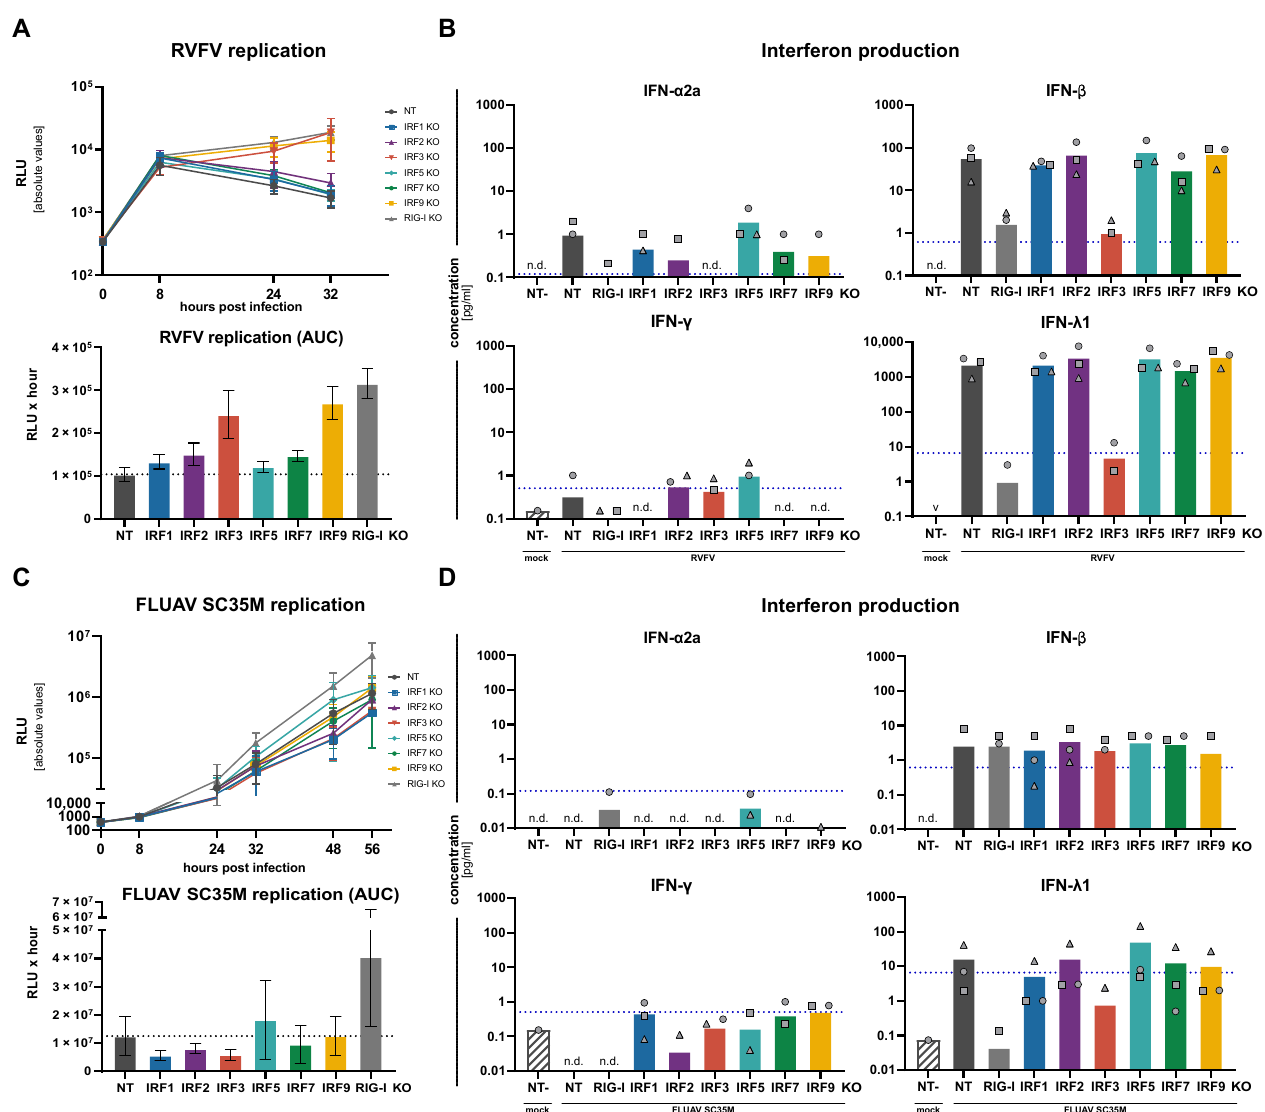
Figure 5. Impact of IRF KO on RNA virus replication and IFN production. A549 NT , A549 IRF (as indicated) KO , and A549 RIG-I KO cells were infected with Rift Valley fever virus (RVFV ∆ NSs-R-Luc) at an MOI of 0.01 ( A , B ), or with Influenza A Virus SC35M (FLUAV SC35M G-Luc) at an MOI of 0.001 ( C , D ). ( A , C ) Viral replication was assessed by measuring luciferase reporter activity at the indicated time points (top panels); the area under the curve (AUC) of the time courses is shown in the lower panels. Viral replication time-courses and AUC plots show mean ± SD of three independent experiments. ( B , D ) Supernatants of the infected cells were sampled at 32 h.p.i. (RVFV, B ) or 48 h.p.i. (FLUAV, D ) and analyzed for their IFN contents by an electroluminescent multiplex assay. Bars show means of three independent experiments with the three individual data points shown as symbols (same shapes indicate same experiment). “n.d.” indicates all measurements were non-detectable, “ ∨ ” indicates all measurements being below the cut-off of the Y-axis, and missing symbols indicate individual measurements below the cut-off or non-detectable. Dashed blue lines indicate the lower limit of quantification (LLoQ) for the respective